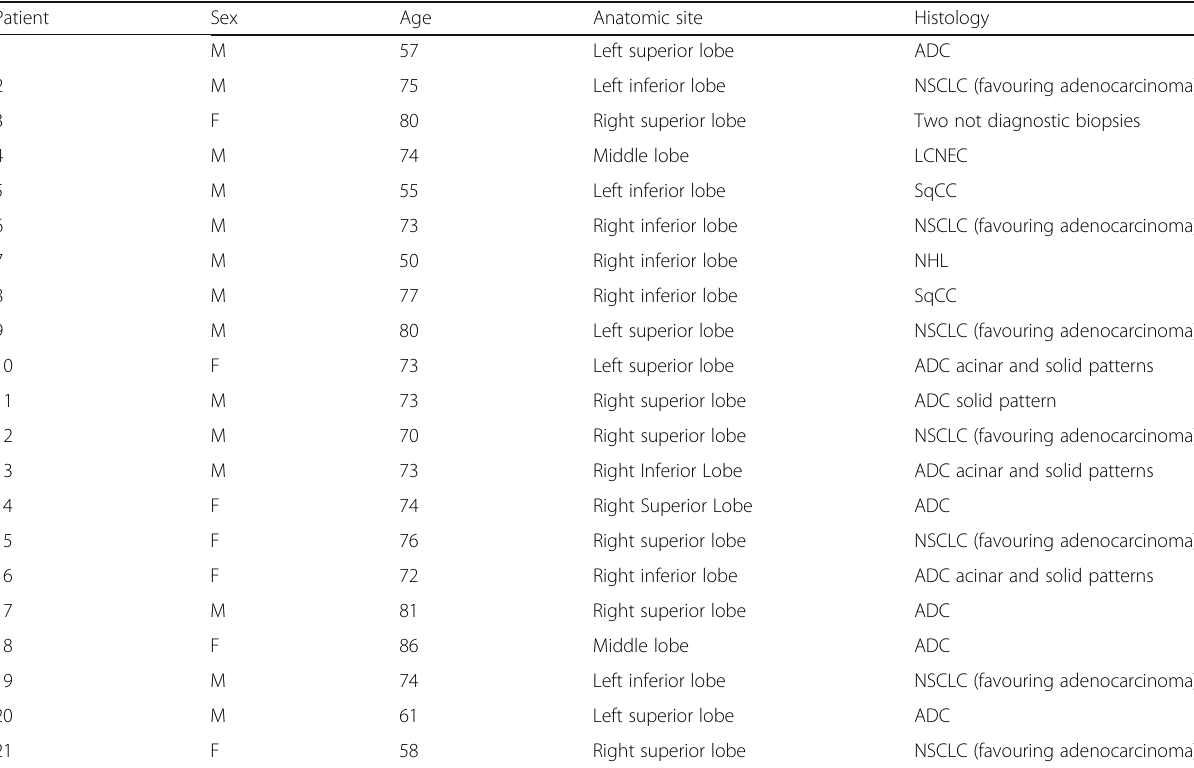
Table 1 Characteristics of the patients